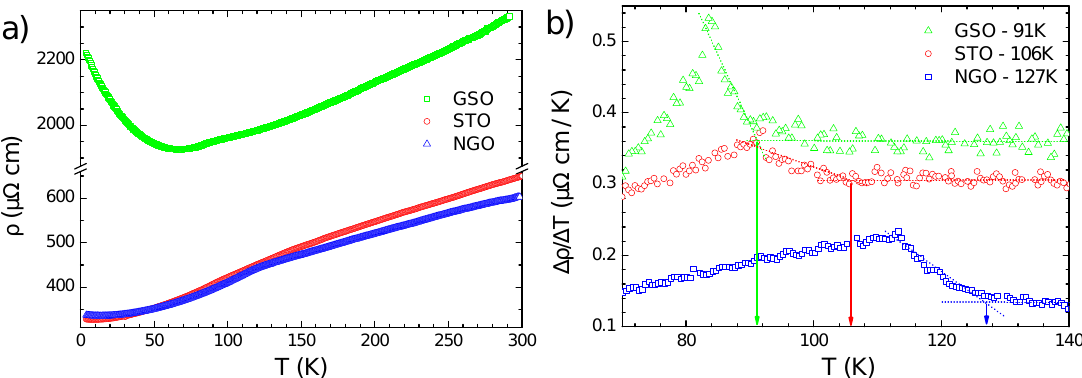
Figure 4. ( a ) Resistivity versus temperature curves for SRO films grown on NGO (blue triangles), STO (red circles) and GSO (green triangles); ( b ) Derivative of resistivity as a function of temperature for the three reported samples (i.e., color code is the